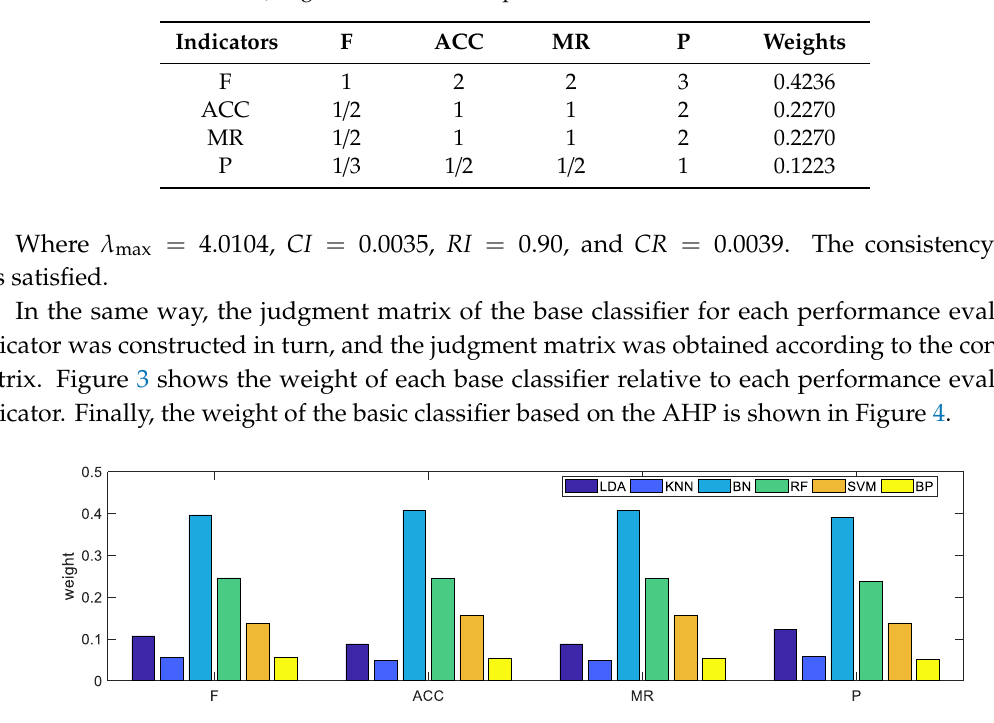
Figure 4. AHP-based classifier weights